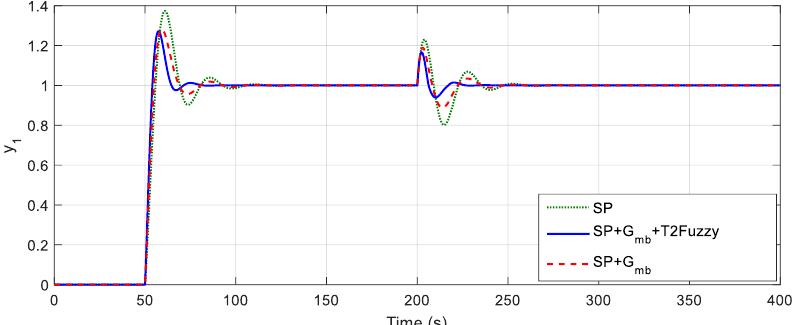
Figure 7. Performance of three control methods for 𝑦 1 for example 1.